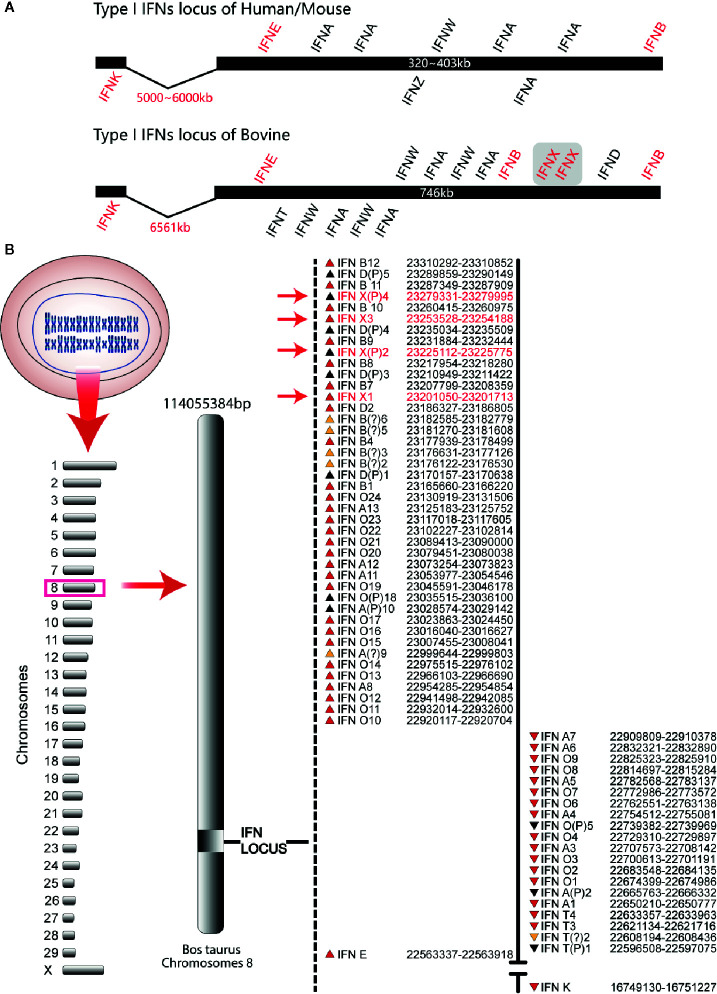
Type-I IFN locus in bovines (schematic). (A) Comparison of the type-I IFN locus. These schematics illustrate the conserved locus of the mouse, human, and bovine but are not drawn to scale. Each IFN gene is represented by its abbreviated name and the position above and below the schematic line represents the direction of transcription. Human/mouse type-I IFN locus was used as control. (B) Gene map of the bovine type-I IFN locus. The known bovine type-I IFN genes reside within two sub-loci. The position of each gene relative to the line and direction of transcription (the arrow direction) is denoted on the map. The subfamily for each gene is designated by the abbreviated name. Pseudogenes are indicated with the letter “P” after the subfamily designation. IFN-χ genes are marked with red font.